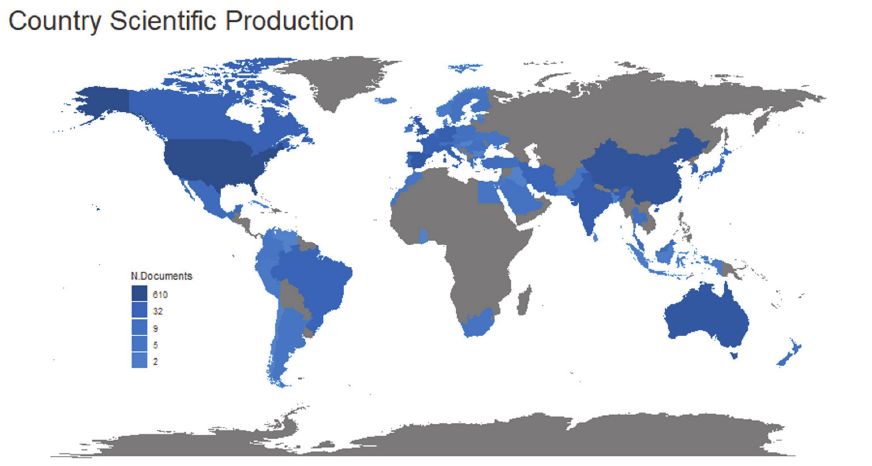
Fig. 4. The frequency of the keywords used in different advertising